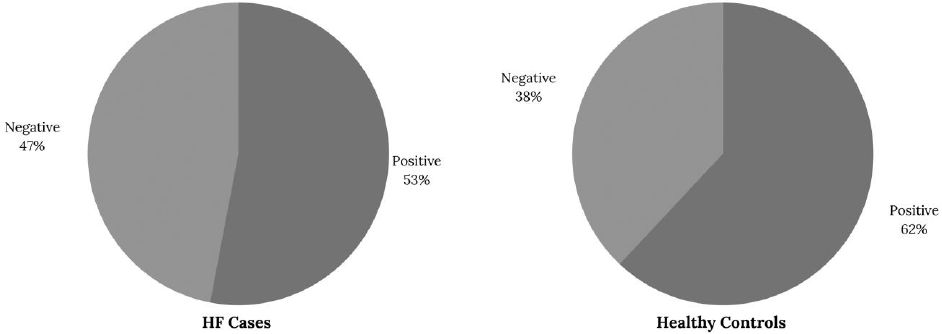
Figure 1. The proportion of patients with positive results for the presence of NAb against at least one of the three serotypes evaluated according to the group.